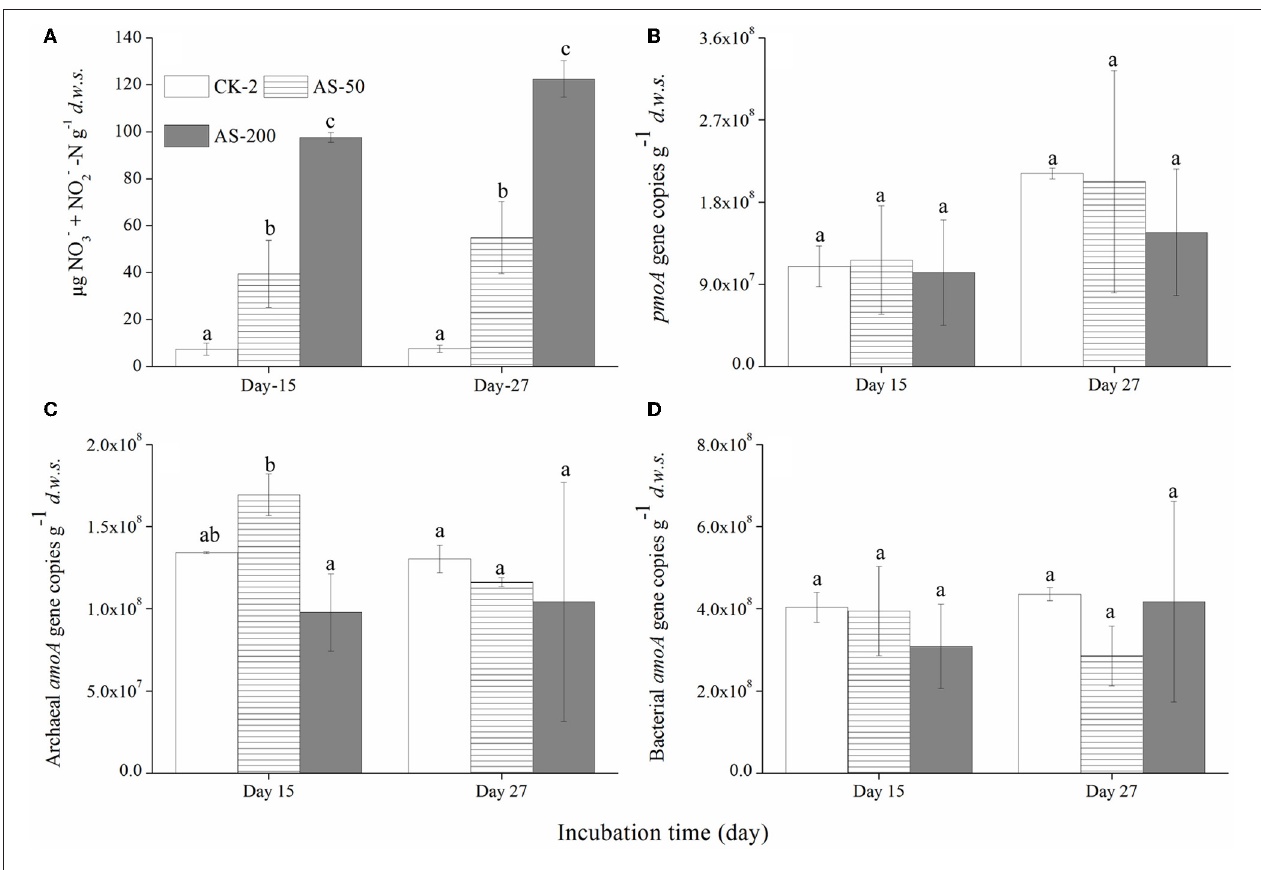
FIGURE 3 | Changes in the concentration of NO − 3 and NO − 3 -N (A) the abundances of the pmoA genes of the methane-oxidizing bacteria (B) and the amoA genes of the Archaea (C) and Bacteria (D) in the soil microcosms amended with ammonium sulfate. The designations